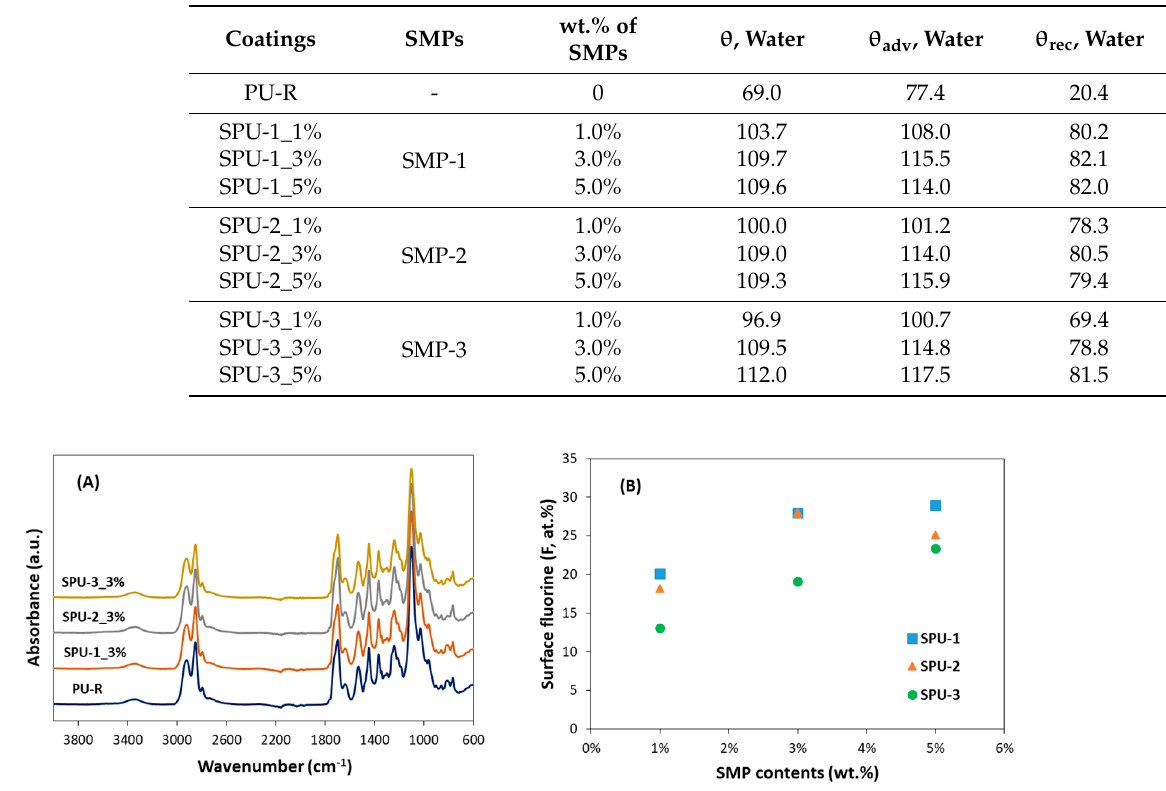
Table 2. Preparation and water contact angle measurements of SPU coatings.